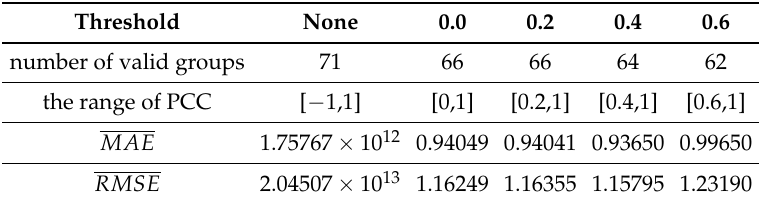
Table 9. Comparison for different thresholds of PCC